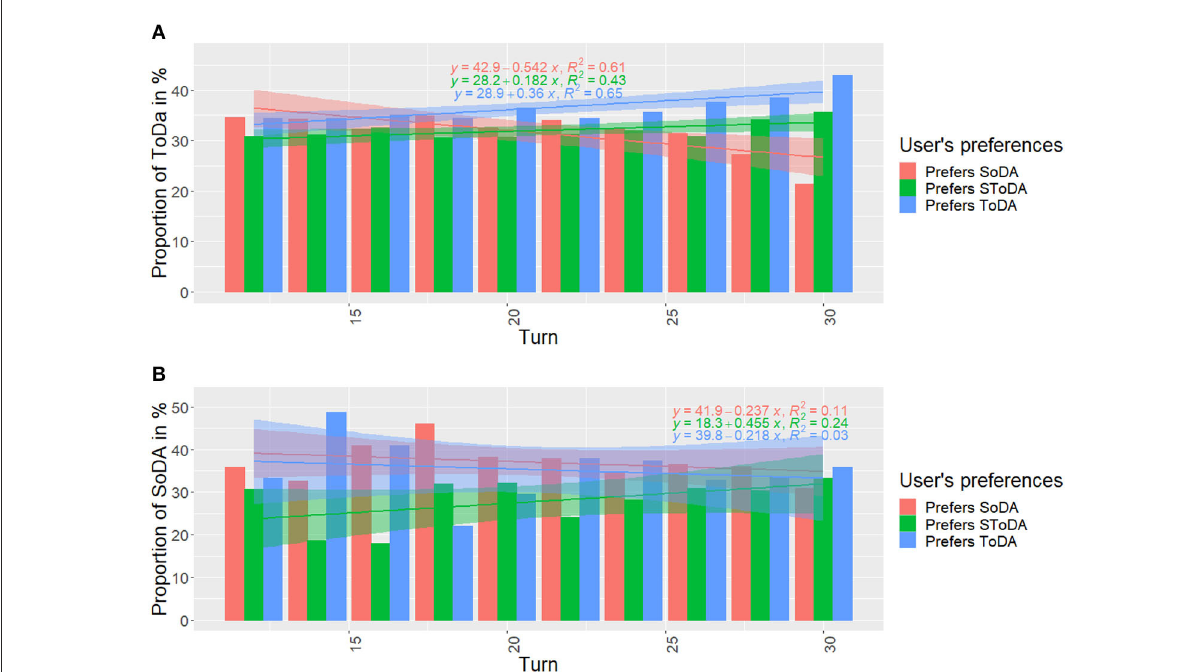
FIGURE7 Distribution in time of task- (A) and socially- (B) oriented dialog acts. SoDA, socially-oriented dialog act; ToDA, task-oriented dialog act; SToDA, socially- and task-oriented dialog